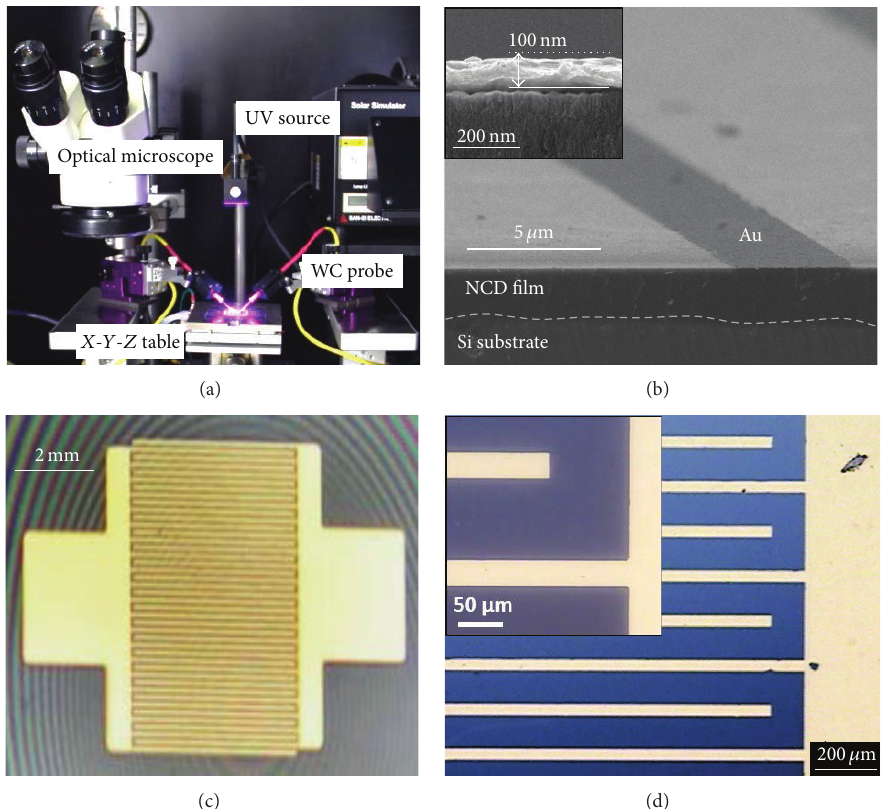
Figure 5: (a) Photovoltaic measurement system, (b) SEM images of the fabricated NCD/Au films, and (c), (d) captured photo and OM images of IDE electrodes on the surface of the NCD film grown at a working pressure of 40